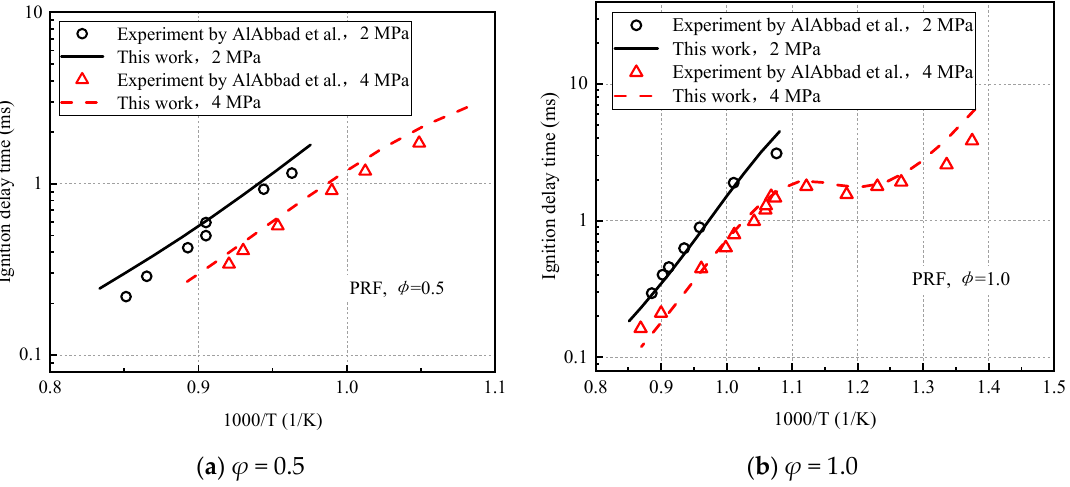
Figure 13. Comparison of ignition delay time calculated by GCI gasoline mixture experiment and model. ( a ) φ = 1.0 and ( b ) φ = 1.0.